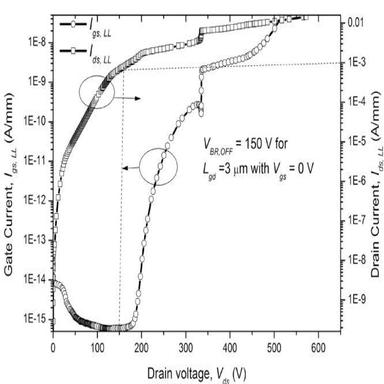
Showing the VBR,OFF characteristics in log scale with length of the field plate (LGFP) in μm and gate to drain (Lgd) of 3 μm for Al0.42ln0.03Ga0.55N MIS-HEMTs observed at the drain current (Ids) of 1 mA/mm and gate voltage (Vgs) of 0 V.